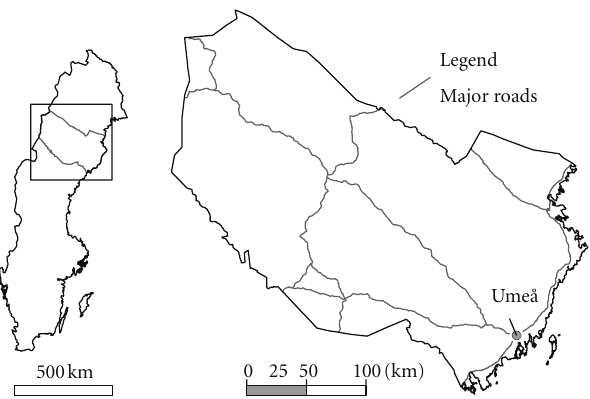
Figure 1: The Swedish county of